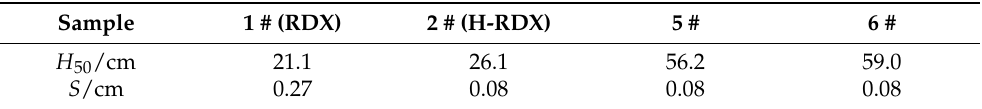
Table 4. Impact sensitivity of different RDX and